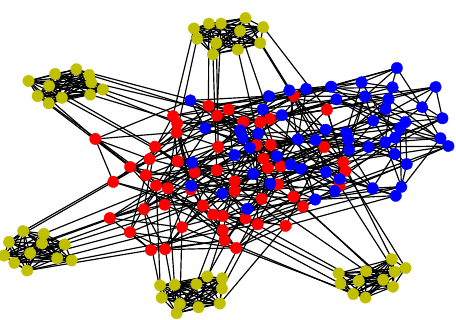
Figure 13. Network of Structure 3.